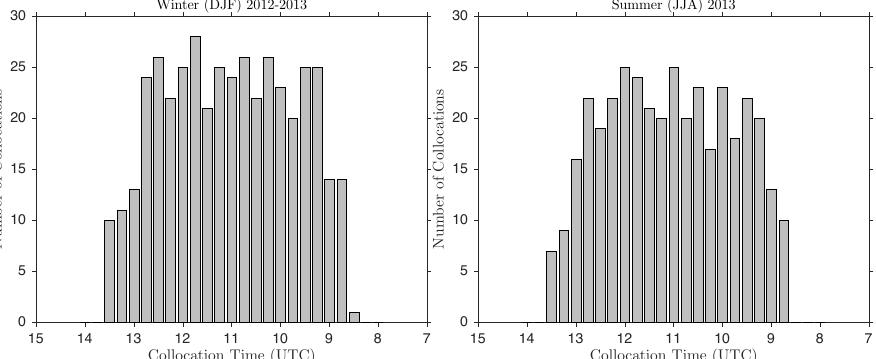
Figure 4. Number of collocations in boreal winter ( left ) and boreal summer ( right ) versus collocation time (time recorded for middle MSG frame in each collocation). Collocations in most eastern part of study area occur at 08:30 UTC, while those in most western part occur at 13:30 UTC (see Figure 3). Total number of collocations is 801 (425 in winter and 376 in